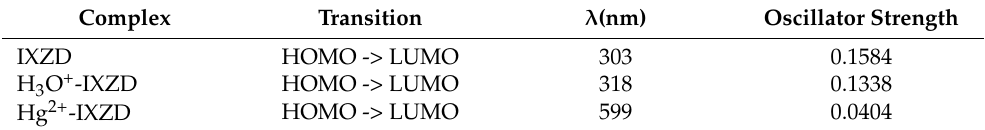
Table 3. TDDFT data of selected electronic transitions, absorption energies, and oscillator